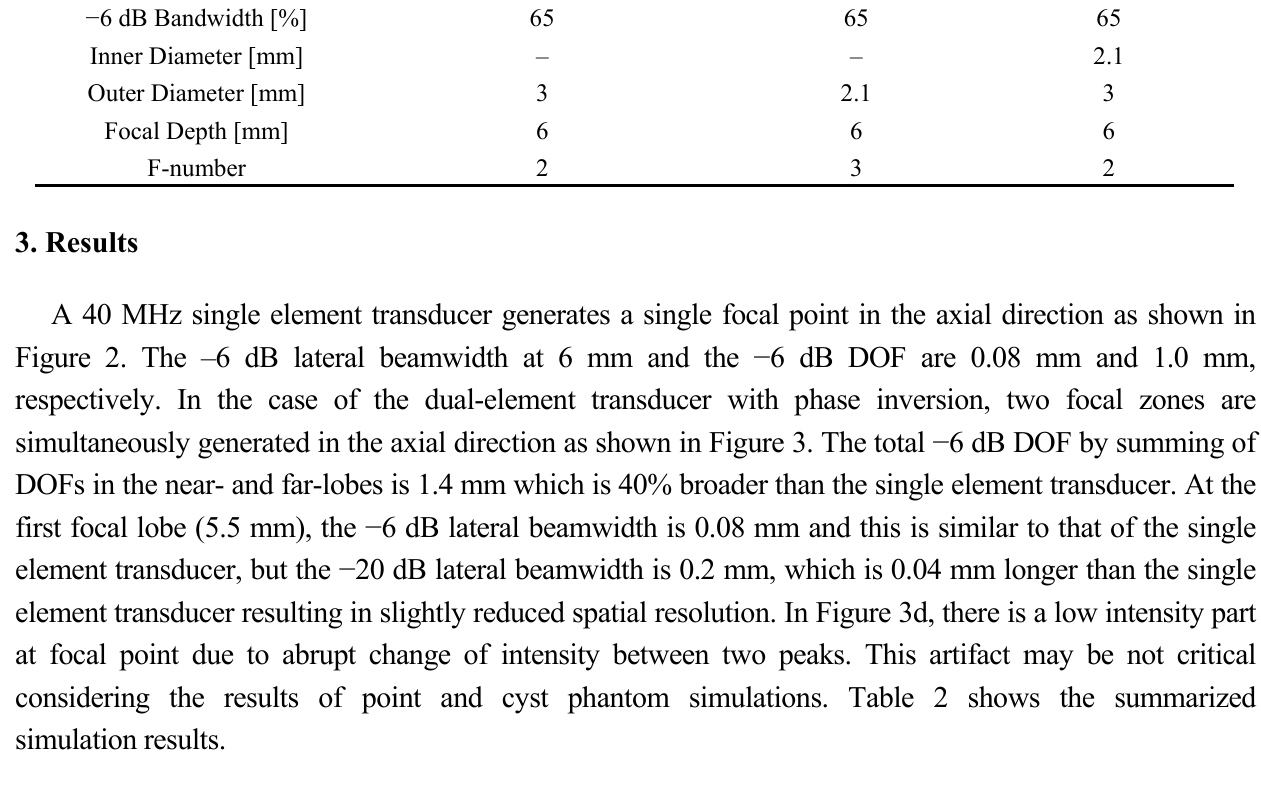
Table 1. Simulation parameters for the single and the dual-element transducer. Dual-Element Transducer Single Element Transducer Inner-Disc Type Outer-Ring